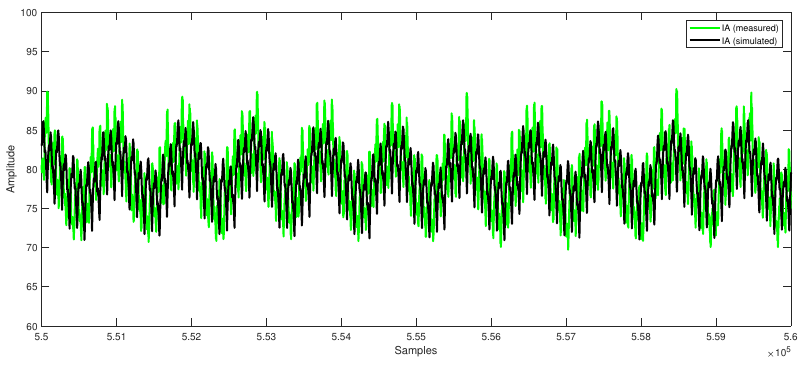
Figure 9. Simulated and measured one phase currents, from 55.5 to 56